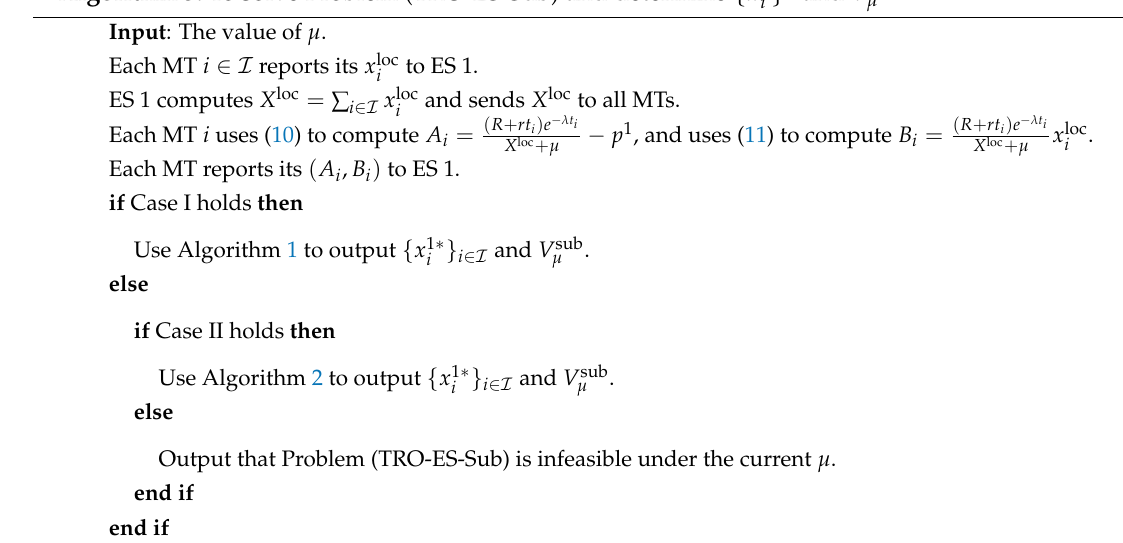
Algorithm 3: To solve Problem (TRO-ES-Sub) and determine { x 1